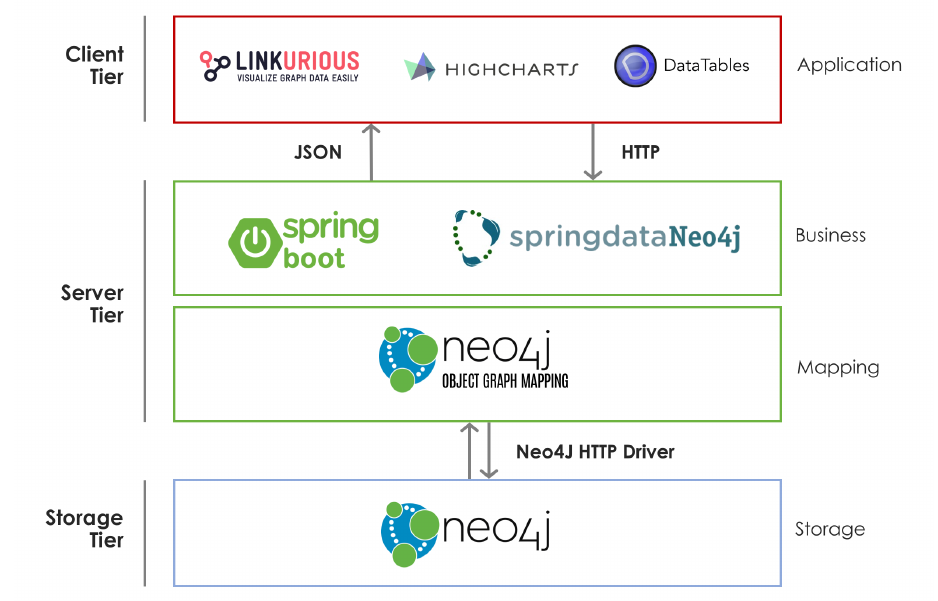
Figure 3. Java EE Spring Data Neo4j framework for CrimeMiner